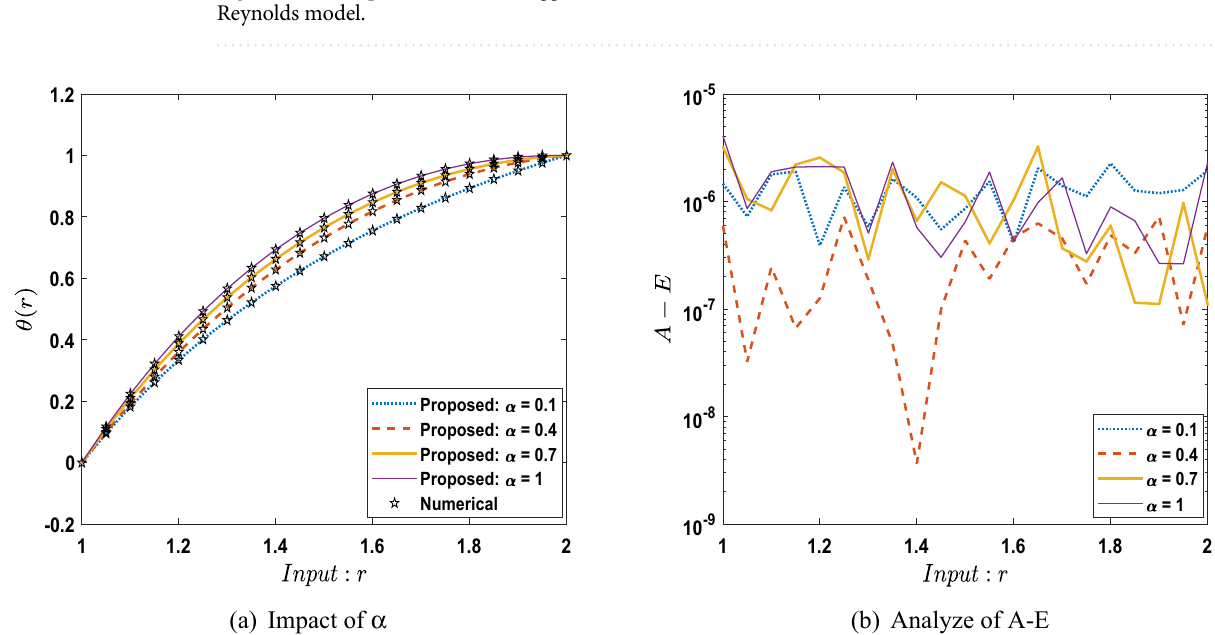
Figure 33. Comparison between suggested LMA-TNN with results of numerical reference for scenario 5 in Reynolds